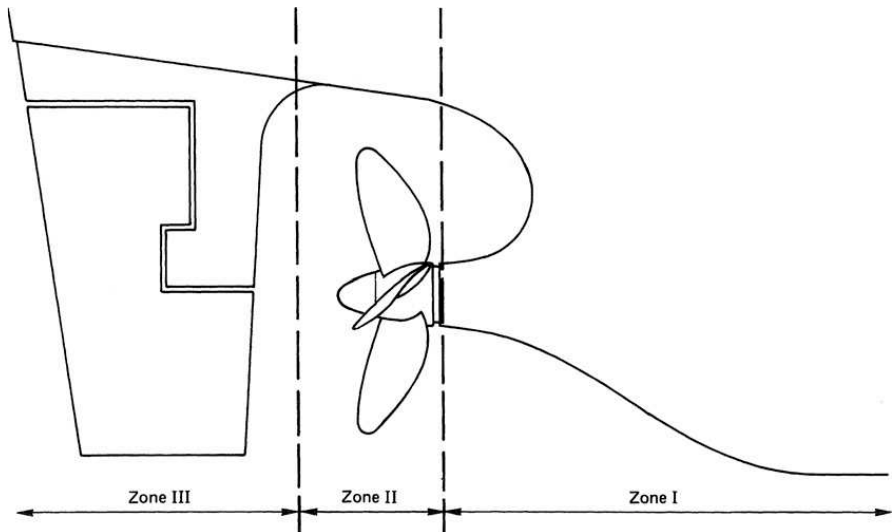
Figure 1. Phases for reduction factors of EEDI [4].